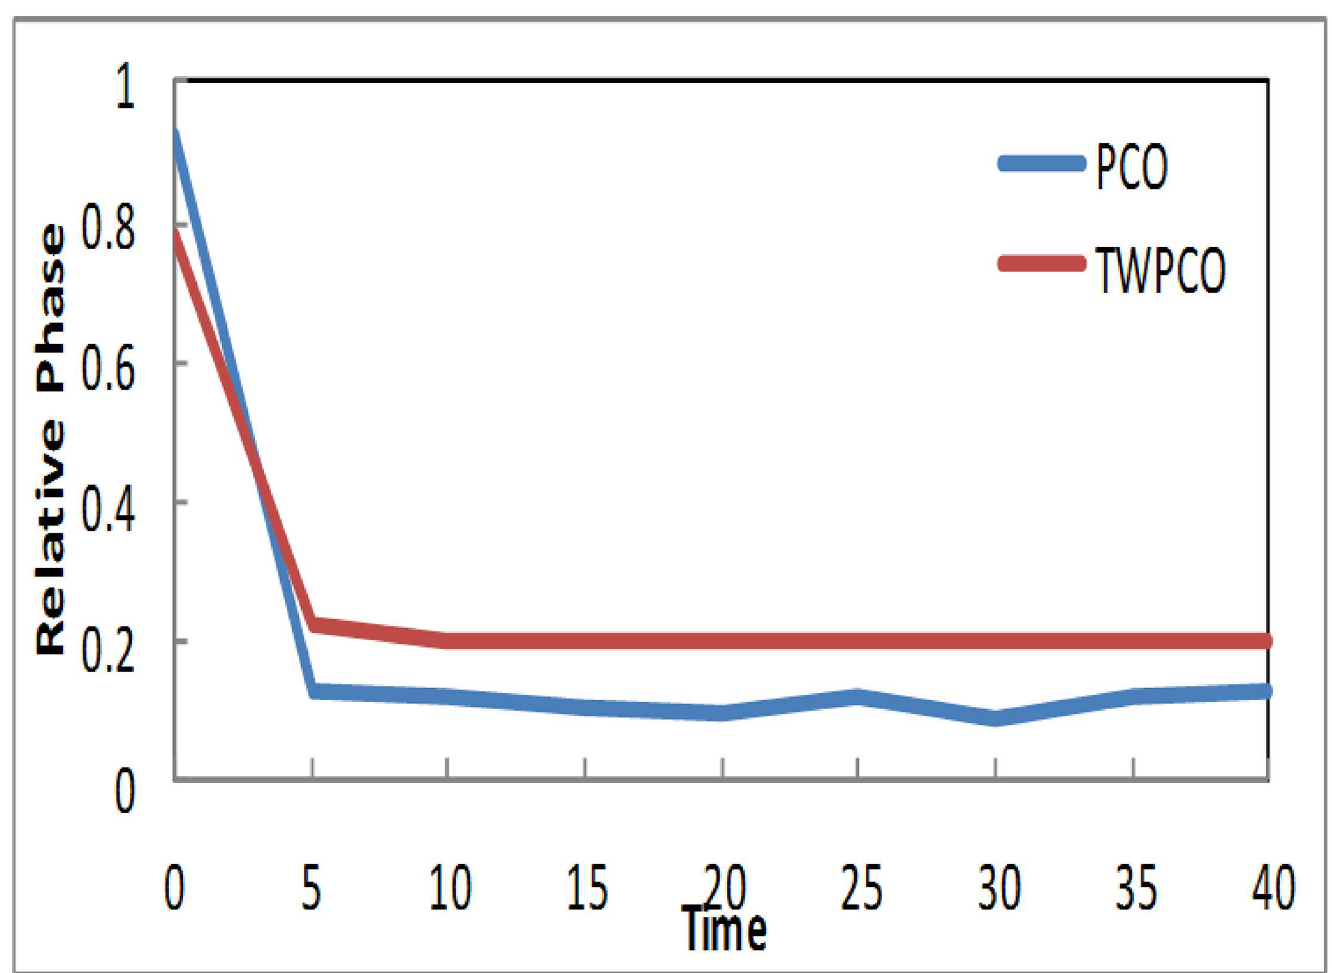
Fig 11. Relative Phase of Sensor TWPCO and PCO in regard to Node